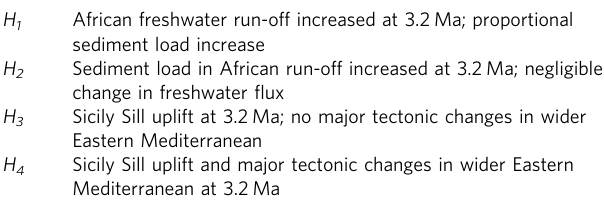
Table 2 Working